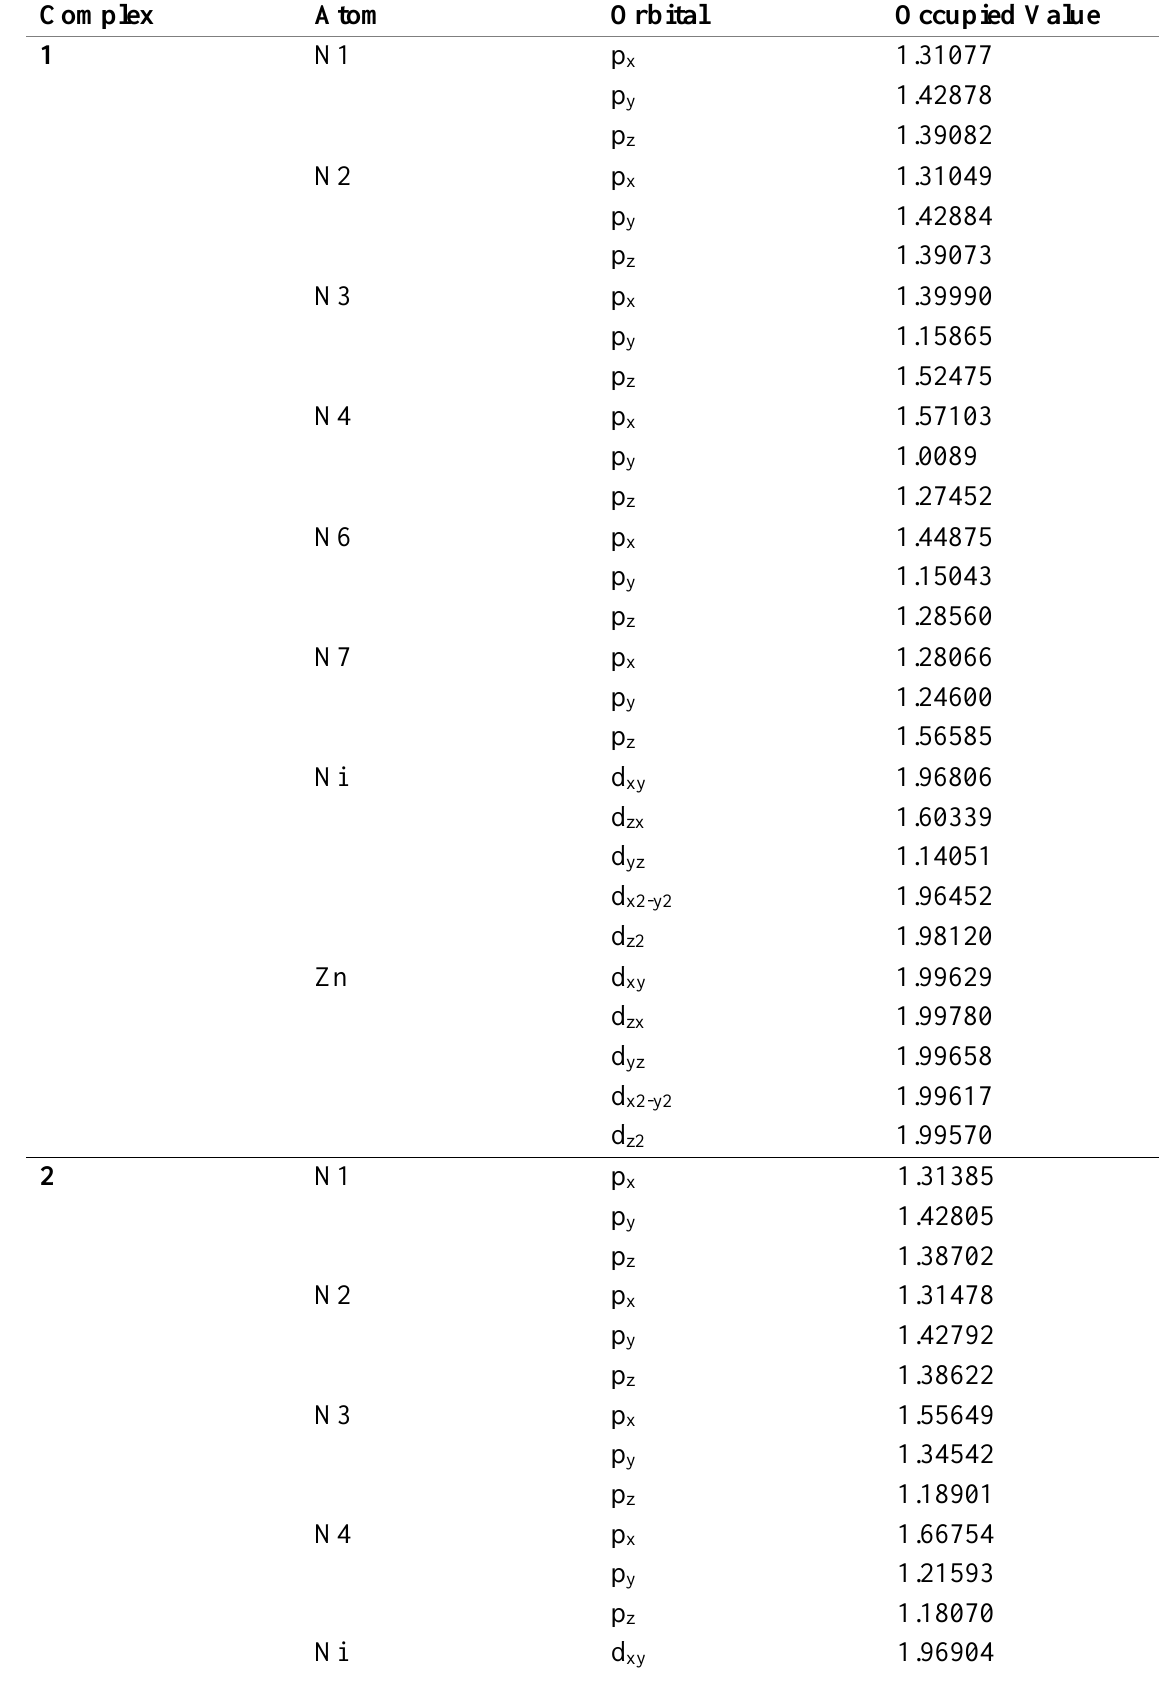
Table S1. The occupancy values of the atom orbitals obtained from the NBO program. Complex Atom Orbital Occupied